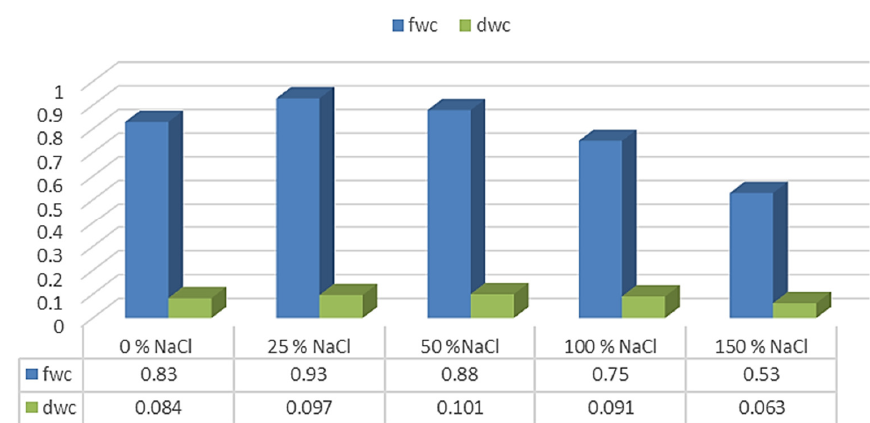
Figure 6. Effect of salt stress on fresh weight coleoptile (FWC) and dry weight coleoptile (DWC)